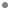
Estimation results for the final epidemic size for 40 countries.Grey dots (•) represent the cumulative numbers of infected cases for 40 countries on May 14th; red dots (•) and horizontal bars (−) represent the posterior means and 95% credible intervals for the θ1 of the 40 countries. Vertical red dotted line indicates the 1, 760, 569 cases, the posterior mean for the US.